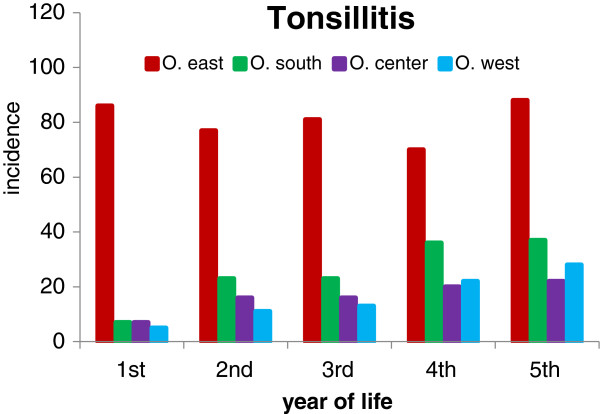
Incidence of tonsillitis per 100 children per year of life. Numbers of children stratified by age and region of residence are presented in Table 3.